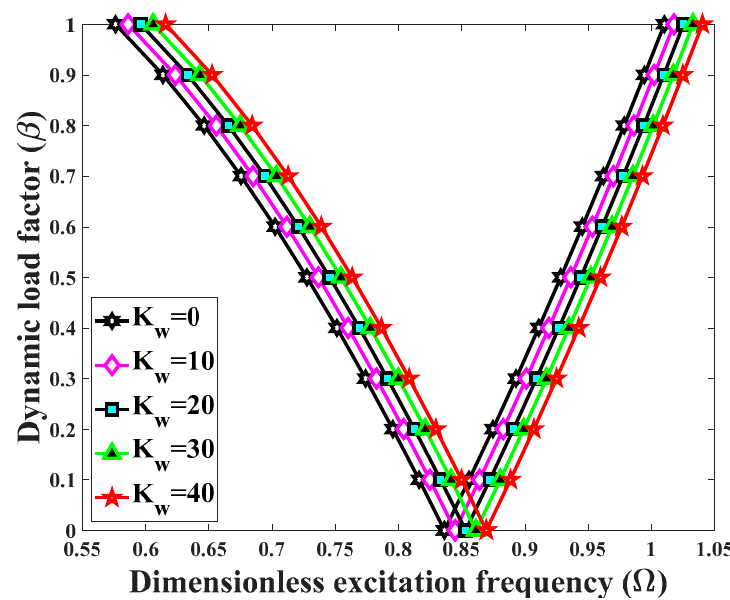
Figure 16. Effect of the Winkler coefficient on the DIR for a BD-FG cylindrical shell with Figure 16. E ff ect of the Winkler coe ffi cient on the DIR for a BD-FG cylindrical shell with R = 0.5 m,